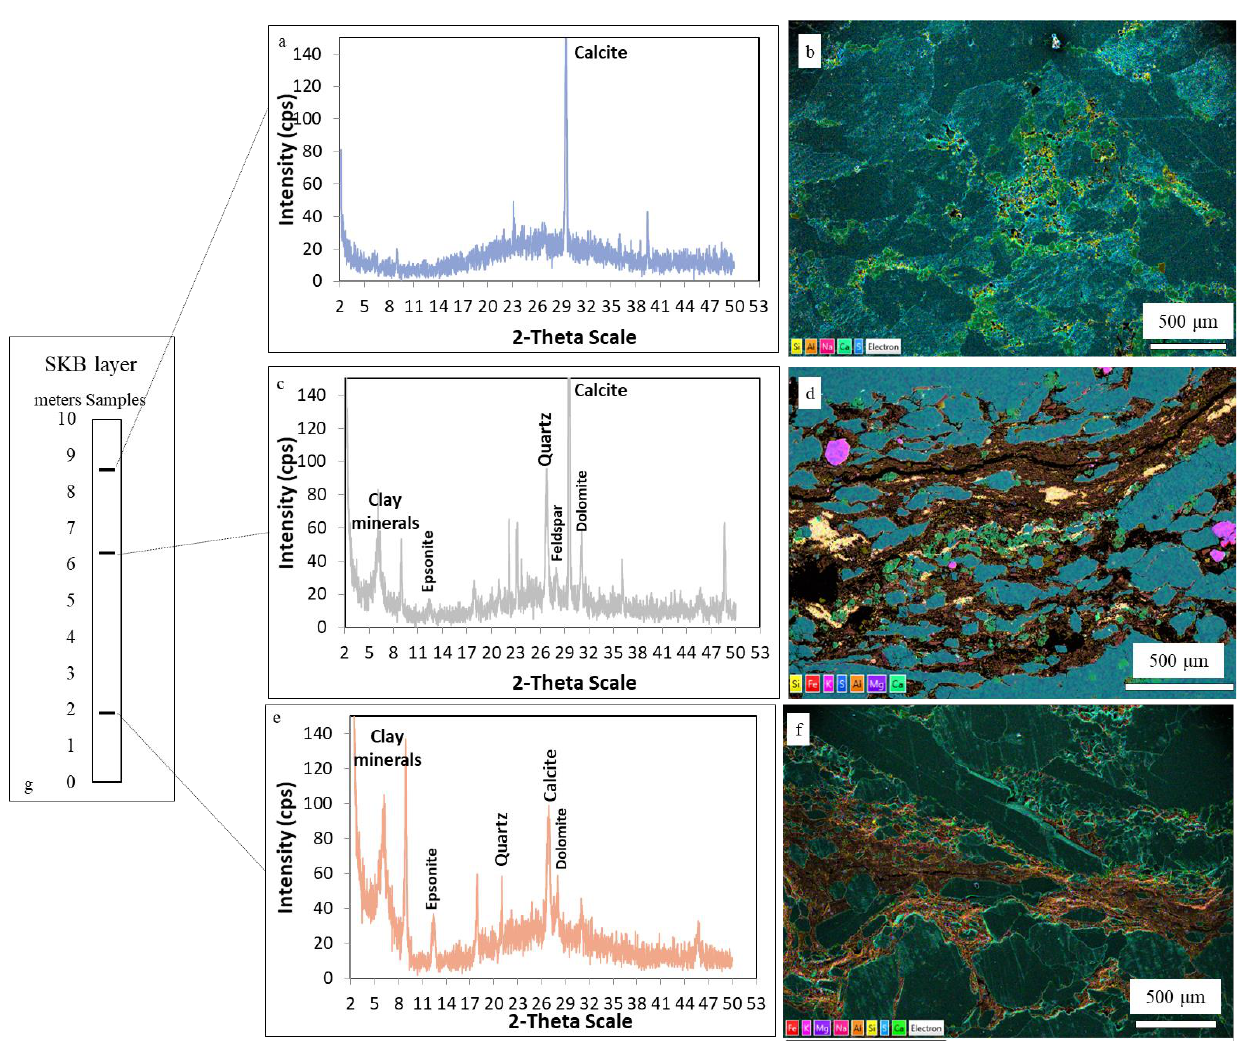
Figure 5. XRPD analyses on the non-gypsum fraction and EDS maps on thin sections of samples from borehole S61. Depth of the samples are: ( a , b ): 78 to 79 m; ( c , d ): 80.6 to 81 m; ( e , f ): 85 to 85.4 m. The SKB layer in this point extends from 77.2 to 87.1 m of depth from the surface. In ( b , f ) the EDS maps are superimposed to SEM micrographs acquired in secondary electron mode. The position of the samples in the SKB layer is reported in ( g ).